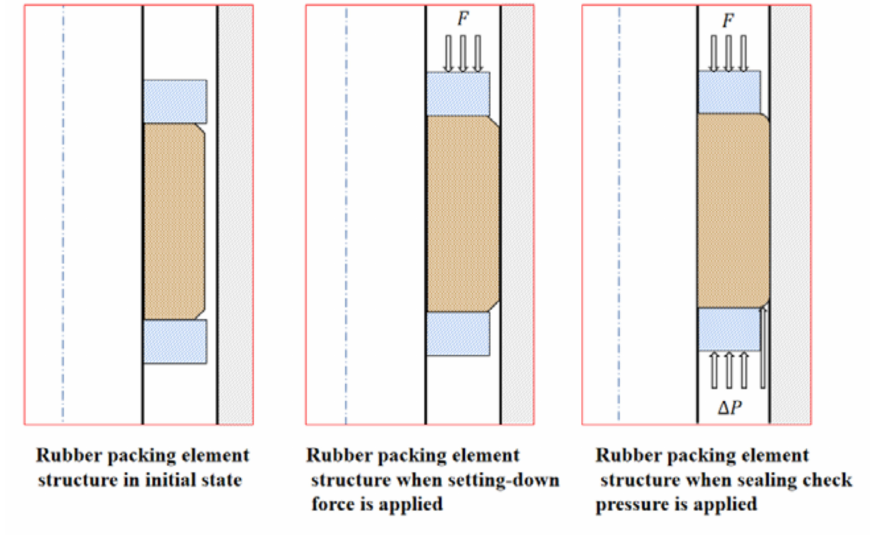
Figure 1. Working principle of the rubber packing